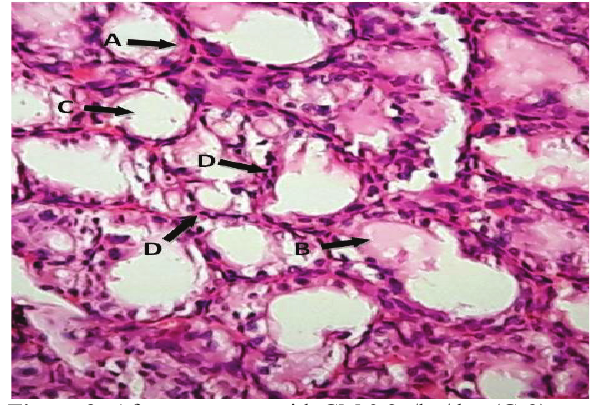
Figure 3: After treatment with CM 0.2g/kg/day (G-3)